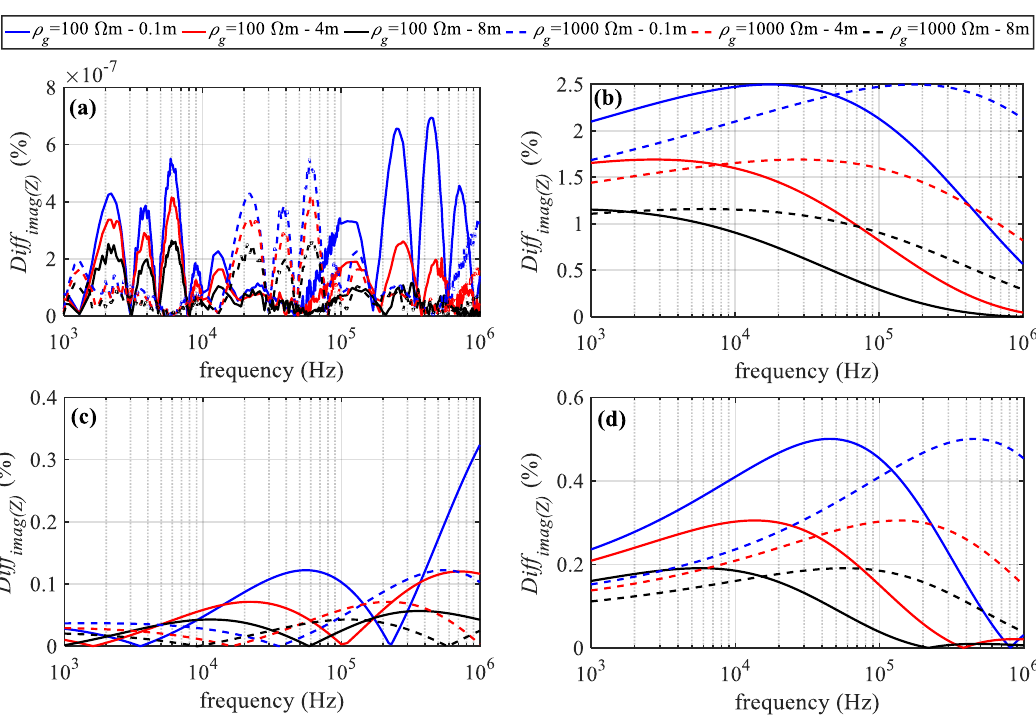
Figure 14. Di ff erences in the imaginary part of Z 13 in NB using the closed-form expression of ( a ) Carson, ( b ) Dubanton ( c ) Noda and ( d ) Alvarado-Betancourt.